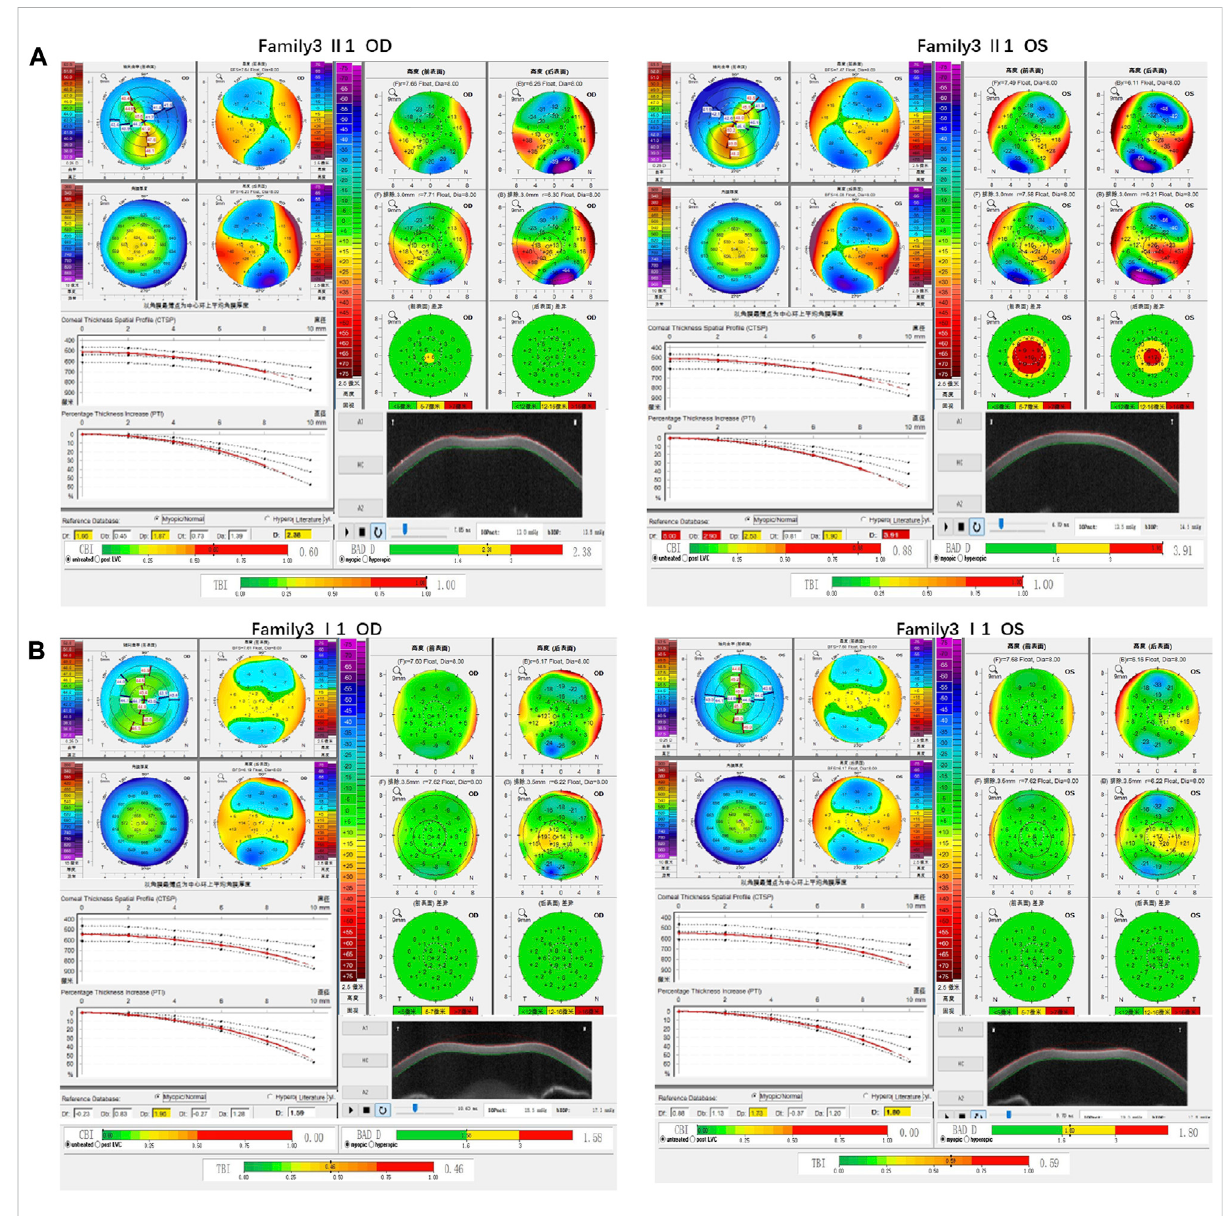
FIGURE 5 Corneal topographic map and corneal biomechanical examination in family3. (A) Kmax, Ef, Eb, Df, Db, Dp, Da, D, BAD-D, CBI and TBI showing pathological values (red) in the proband. (B) TDp, BAD-D, TBI is showing suspicious values (yellow) in the father of proband.